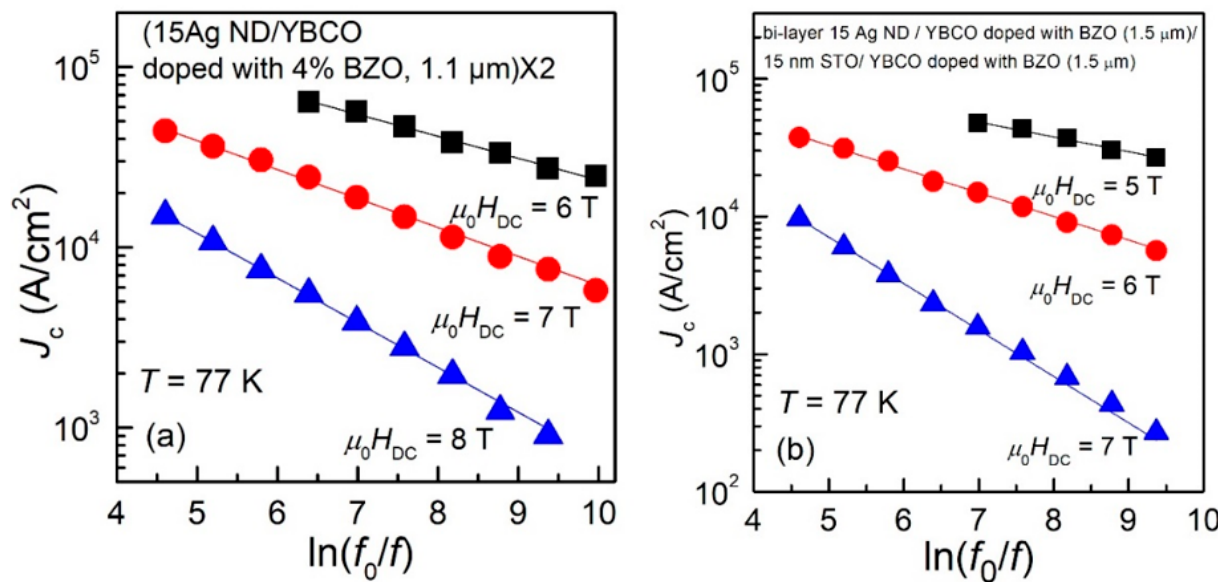
Figure 6. Frequency dependence of the critical current density of Sample 5 ( a ) and Sample 6 ( b ), at 77 K and in DC fields indicated in the figure. All the dependences are very well described by straight lines in the double-logarithmic plot.